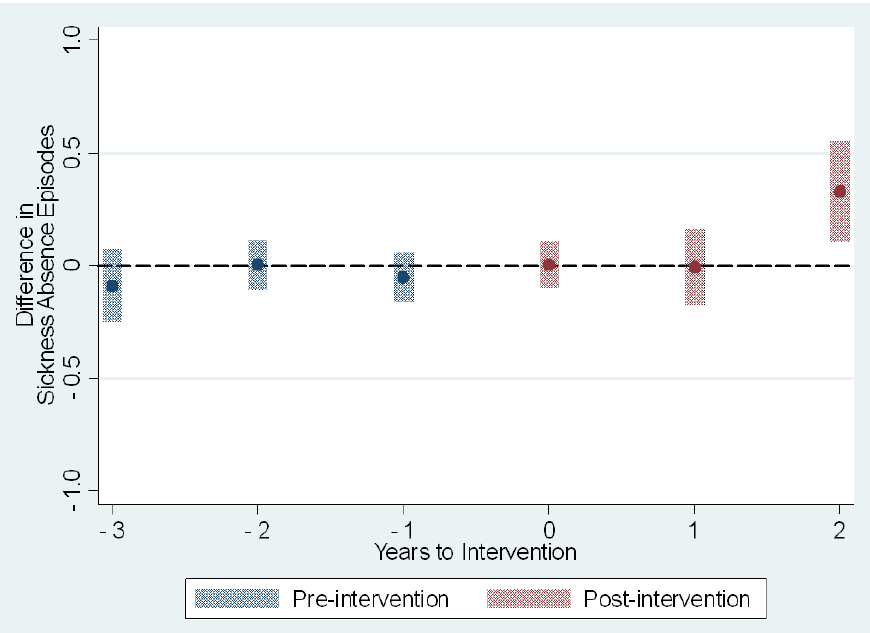
Figure 4. The estimated dynamic average treatment effects of the use of the participatory scheduling tool with shift schedule evaluation tool on sickness absence episodes from all sickness absences. Event study estimates with 95% confidence intervals depict difference in outcome measure between intervention and control groups relative to timing of the intervention. Year 0 is the first full year of the intervention.